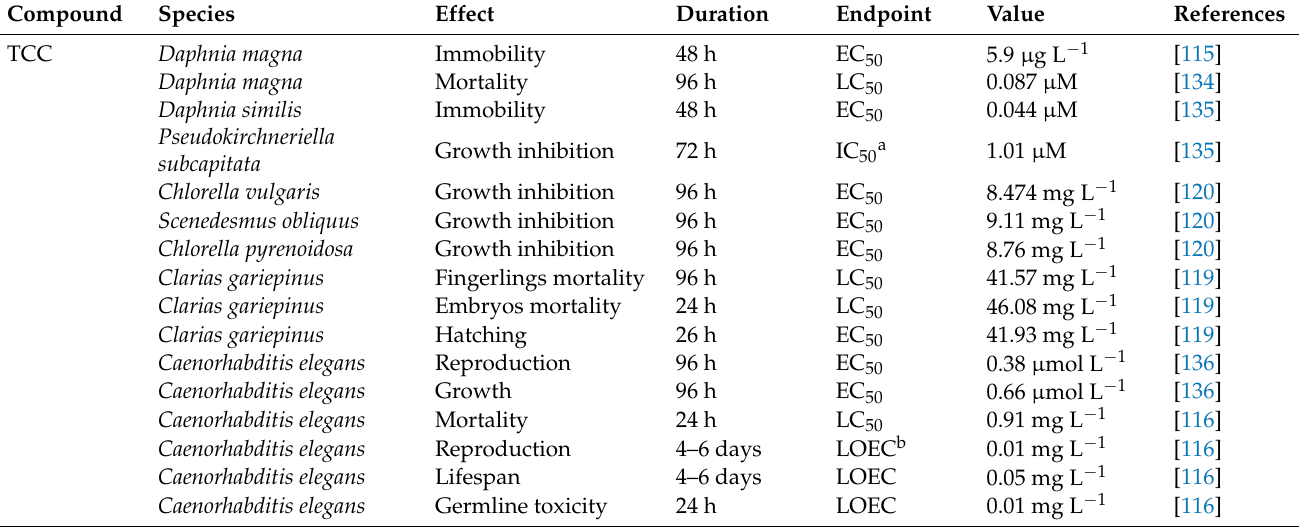
Table 3. Aquatic toxicity values for